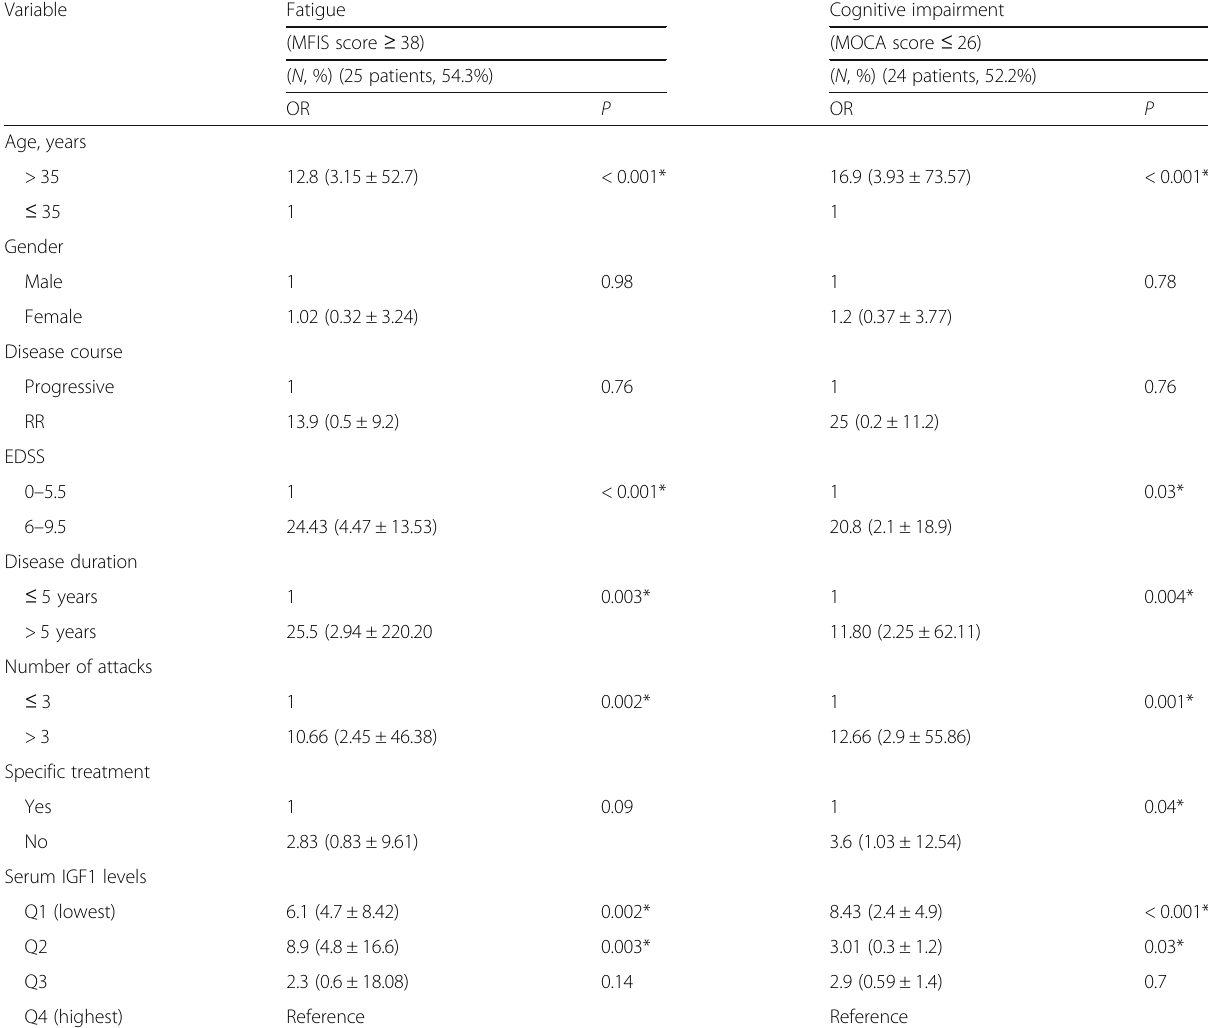
Table 2 Risk factors of fatigue and cognitive impairment among MS patients Variable Fatigue